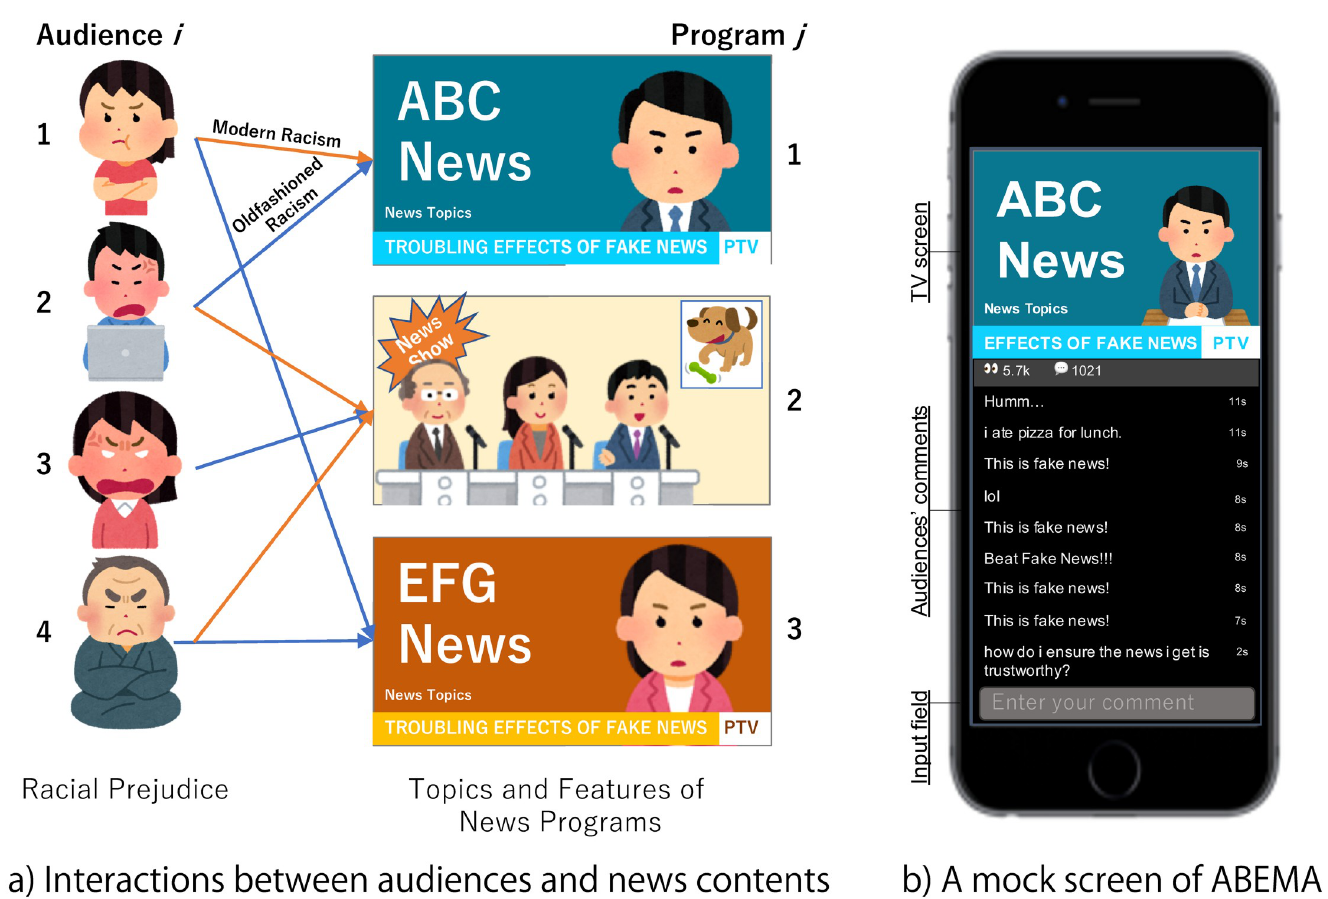
Fig 1. Online television and audiences. (a) Racial prejudice expression is a result of the interaction between news topics and two types of racial prejudice. (b) Audiences can share their opinions as comments while watching news.